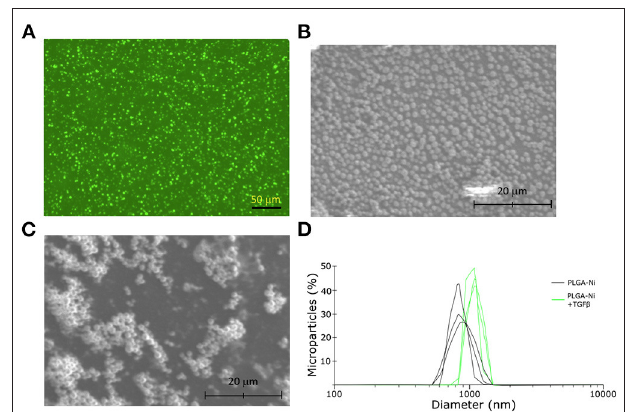
FIGURE 1 | Physical characteristics of the PLGA-Ni microparticles. (A) Fluorescence microscopy image of His-tagged GFP admixed with PLGA-Ni microparticle suspensions. Autofluorescence has been subtracted from the image. Scanning electron microscopy images of PLGA-Ni without (B) and with (C) adsorbed TGF β 1. (D) A histogram of hydrodynamic microparticle size of PLGA-Ni alone or with His-tagged TGF β 1, reveals hydrodynamic diameters (D h ) of 867.5 ± 41.6nm (PDI = 0.18) and 1,088.6 ± 15.6nm (PDI = 0.15),